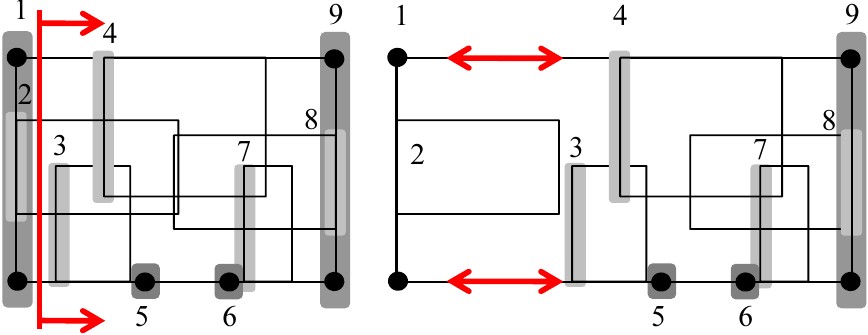
Figure 14. The step of the plane sweep algorithm that resolves overlaps for Label 2.